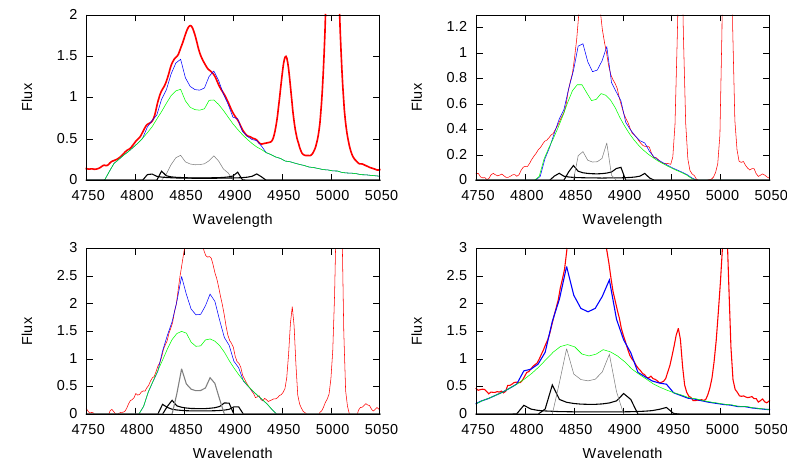
Figure 2. A few examples of AD + ring model matching the broad H β emission line profiles.